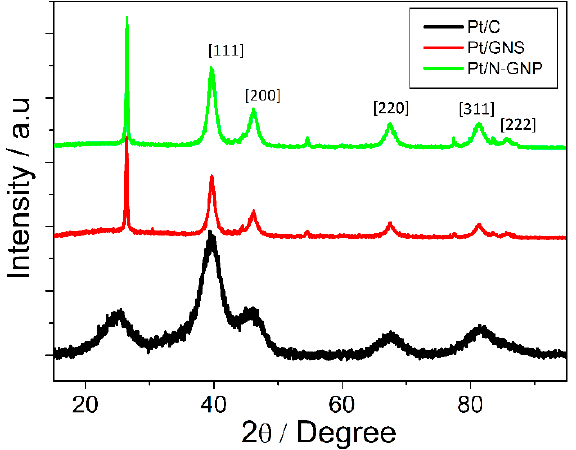
Figure 2. The X-ray diffraction technique (XRD) patterns of Pt/C, Pt/GNS, and Pt/N-GNP catalysts. Table 1. Pt mass by Dispersive Energy (EDX) and thermogravimetric analysis (TGA) measurements, Pt lattice parameter and crystallite size by XRD analysis, and Pt particle size by Transmission Electronic Microscopy (TEM) micrographs of Pt/C, Pt/GNS, and Pt/N-GNP(d n : number averaged particle size and d G: average Gaussian Pt particle size).